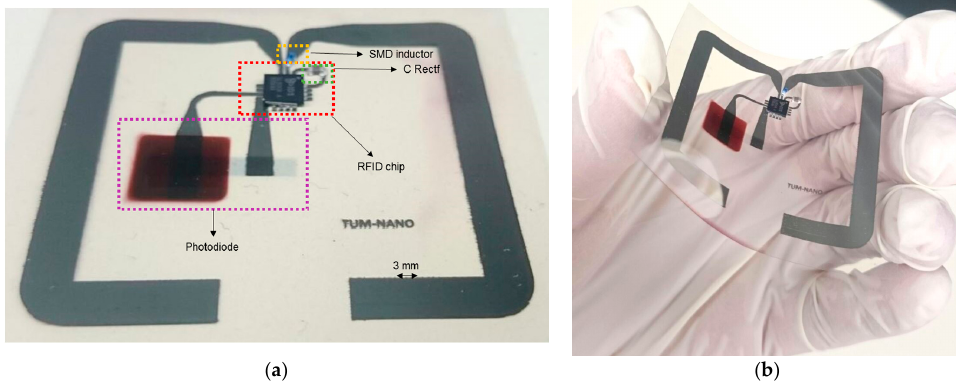
Figure 4. ( a ) image of the tag with all its elements labelled; ( b ) image of the tag.